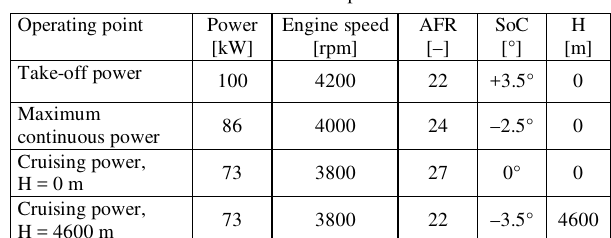
Fig. 2. Model of the engine with the Eaton TVS R900 mechanical com- pressor Table 3. Defined operating points for the variant with the Garrett GT- 2560R turbocharger and the Eaton TVS R410 mechanical